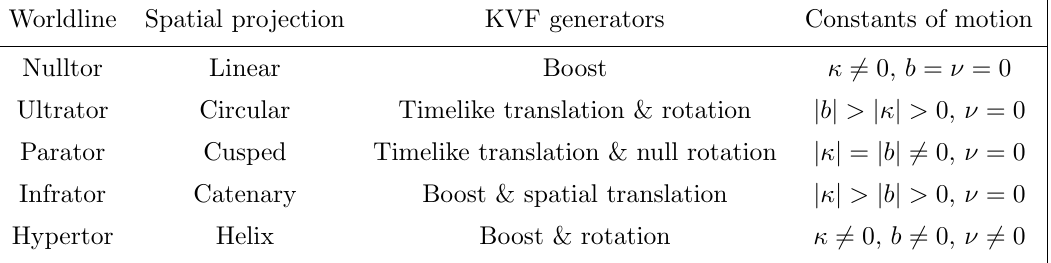
Table 1 . Stationary accelerated